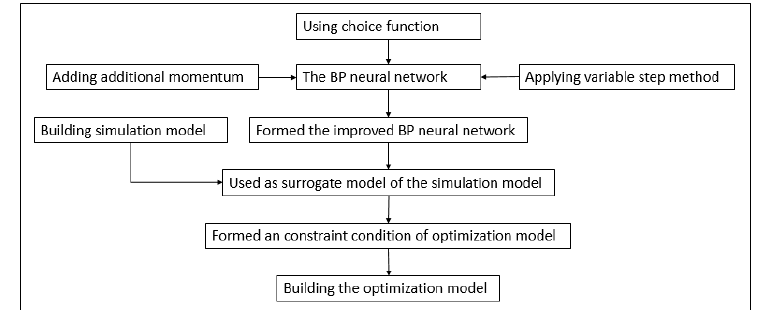
Figure 2. The workflow of the surrogate model built and used.